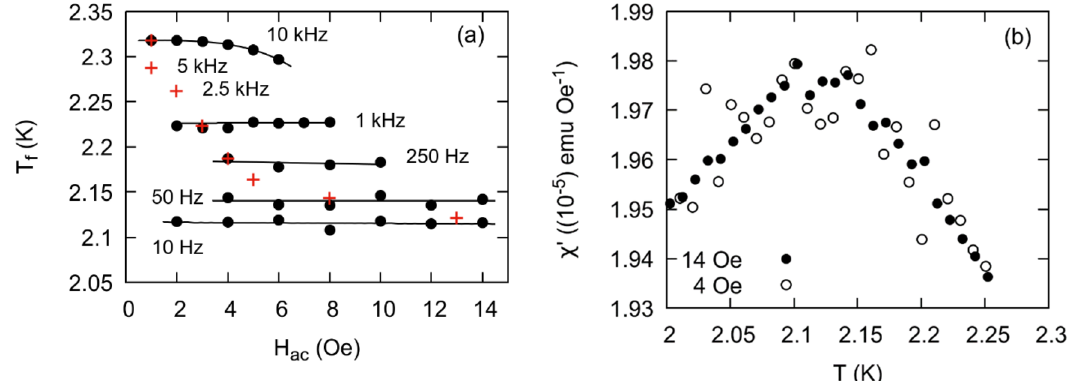
Figure 9. (a) Black dots indicate T f as a function of H ac at different frequencies. Results are shown for x = 0. Red crosses indicate H ac magnitudes chosen for different frequencies for reported results in Tables 2, 3, and 4. Values were chosen to maximize measurement signal and minimize a nonlinear response. Black lines are introduced as a guide for the eye. (b) Peak in χ ′ ( T ) at 10 Hz and driving fields of 4 and 14 Oe.